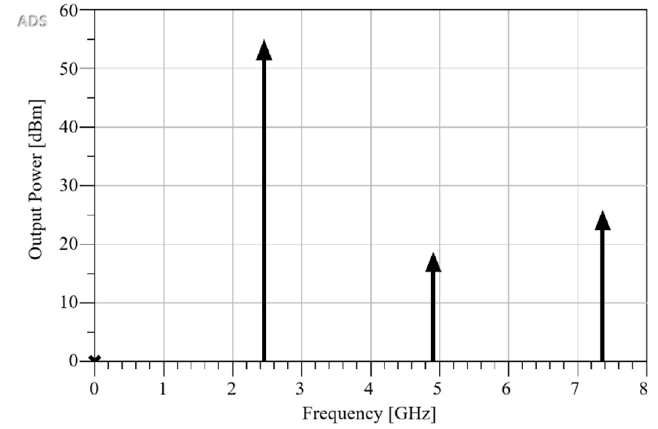
Figure 8. Simulated output spectrum of the high-power oscillator.